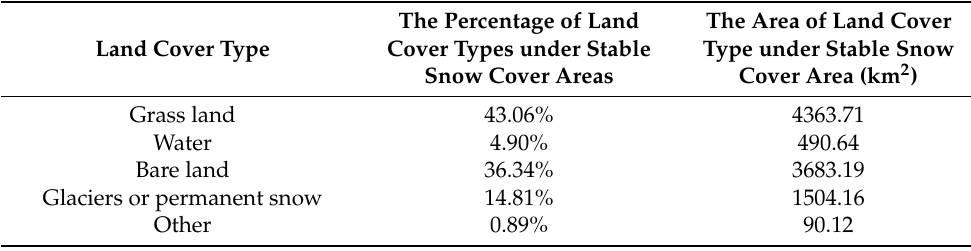
Table 1. Land cover types under stable snow